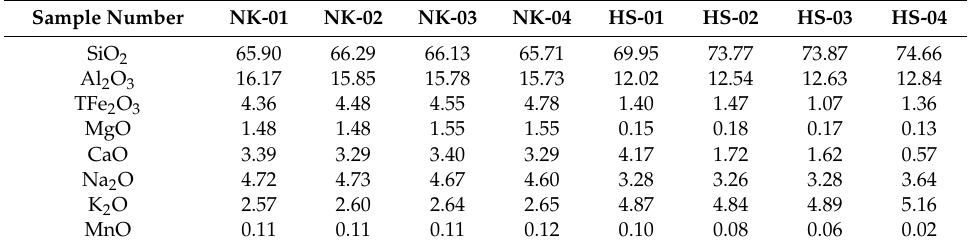
Table 2. The major chemical compositions (in wt%) and calculated parameters of the North-Karamay granitoids and the Hongshan